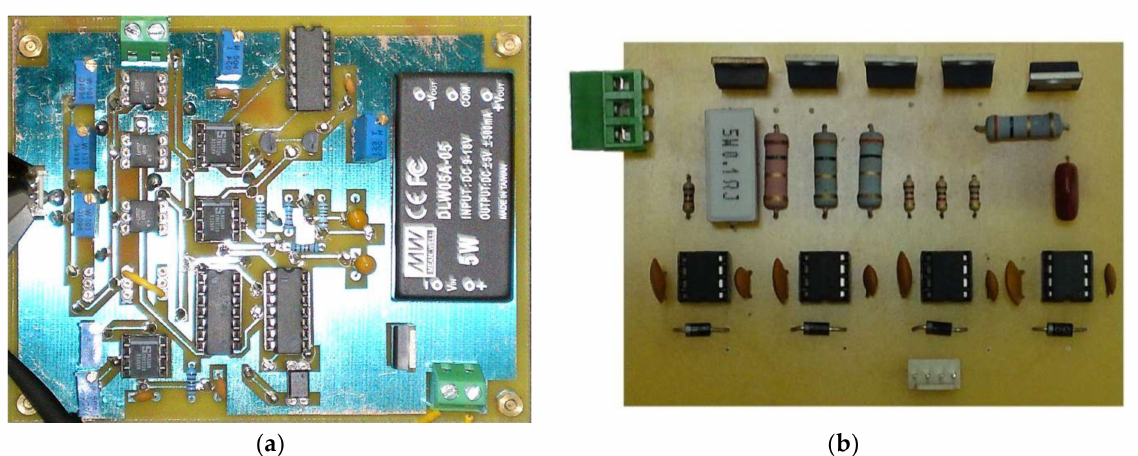
Figure 4. The three-pulse MOSFET injector signal control and driving circuit board. ( a ) Logic operation and driving signal circuit. ( b ) Three-pulse MOSFET driving circuit board.